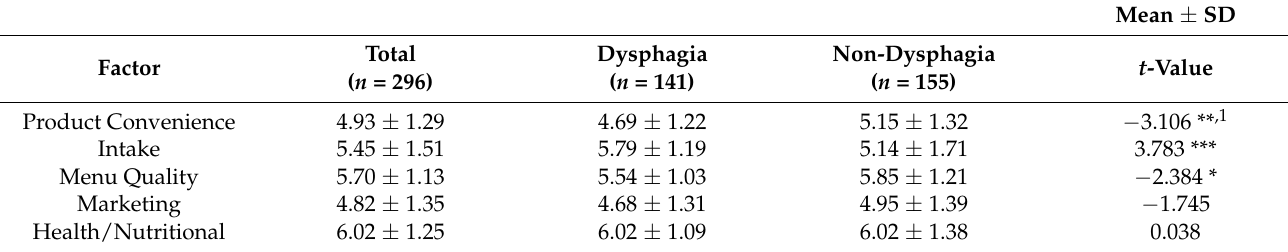
Table 4. Attributes of the selection of food products in the dysphagia and non-dysphagia groups.